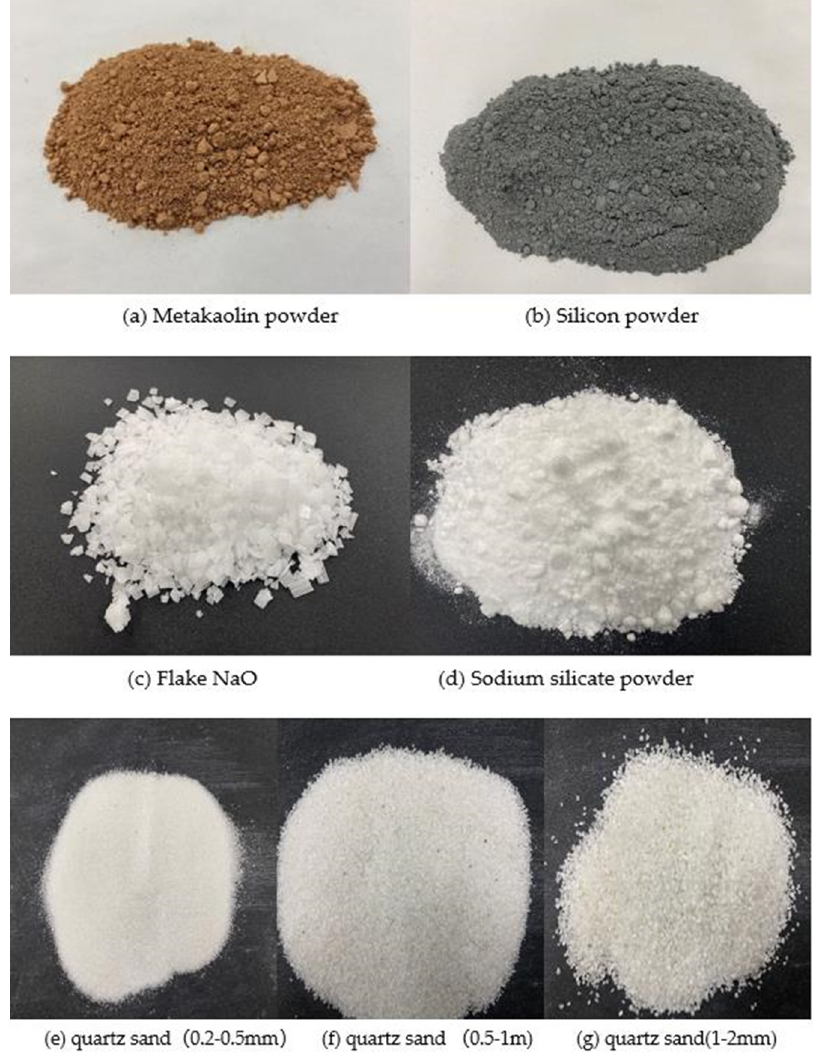
Figure 2. Appearance of raw materials. Table 4. Chemical composition of quartz